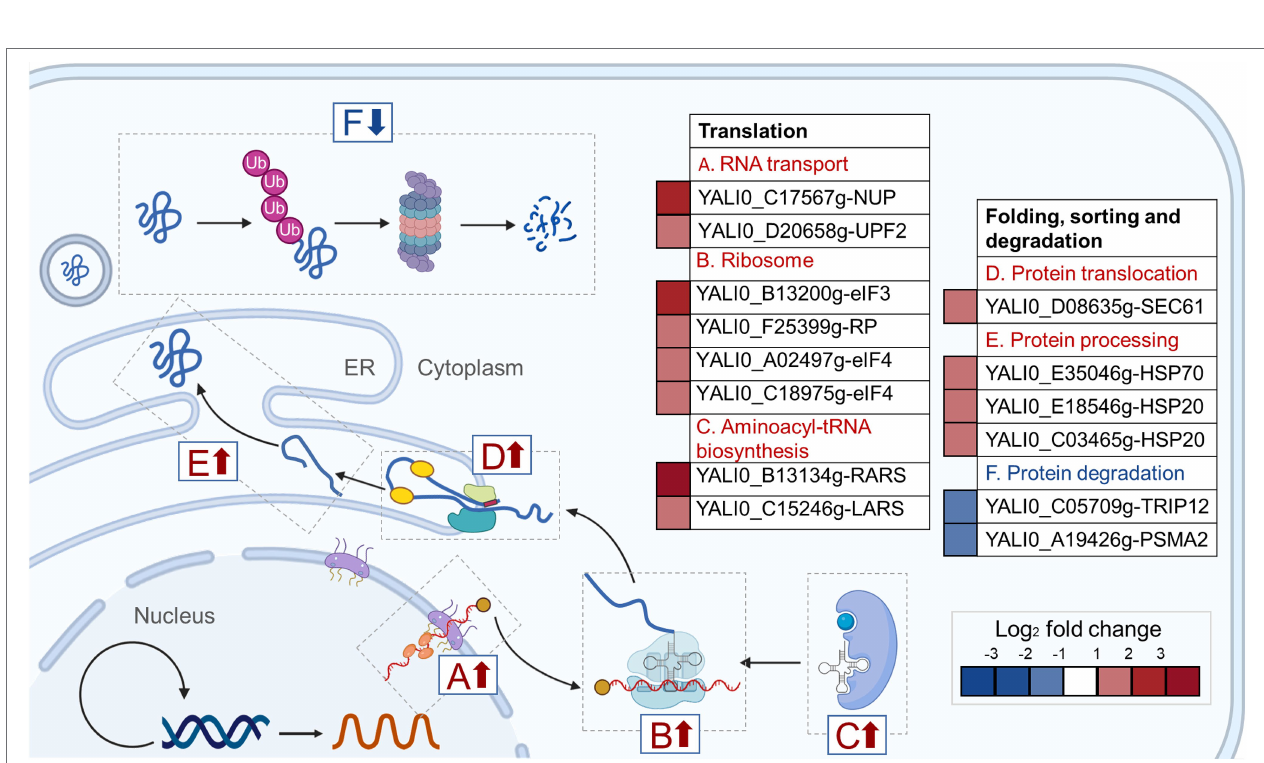
FIGURE 5 | Changes in transcript levels of the protein synthesis process. The (A) RNA transport, (B) Ribosome and (C) Aminoacyl-tRNA synthesis pathway belong to the translation gene set, the (D) protein translocation, and (E) protein processing and (F) protein degradation pathway belong to the folding, sorting and degradation gene set. Among the six pathways, the up- and down-regulated pathways are marked with red and blue arrows, respectively. The boxes indicate fold- change in gene expression of Yl Δ A1-FAR compared to WT-FAR control. Red boxes indicate upregulated gene expression, and blue boxes indicate downregulation gene expression ( p < 0.05).